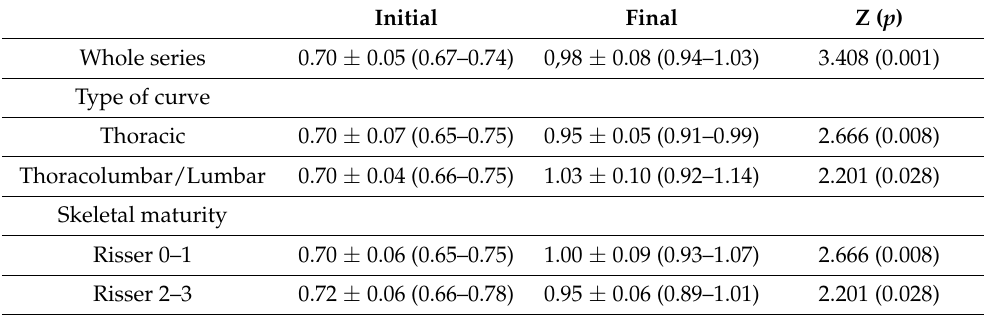
Table 4. Vertebral modulation analyzed at the vertebral apex using the wedging ratio.